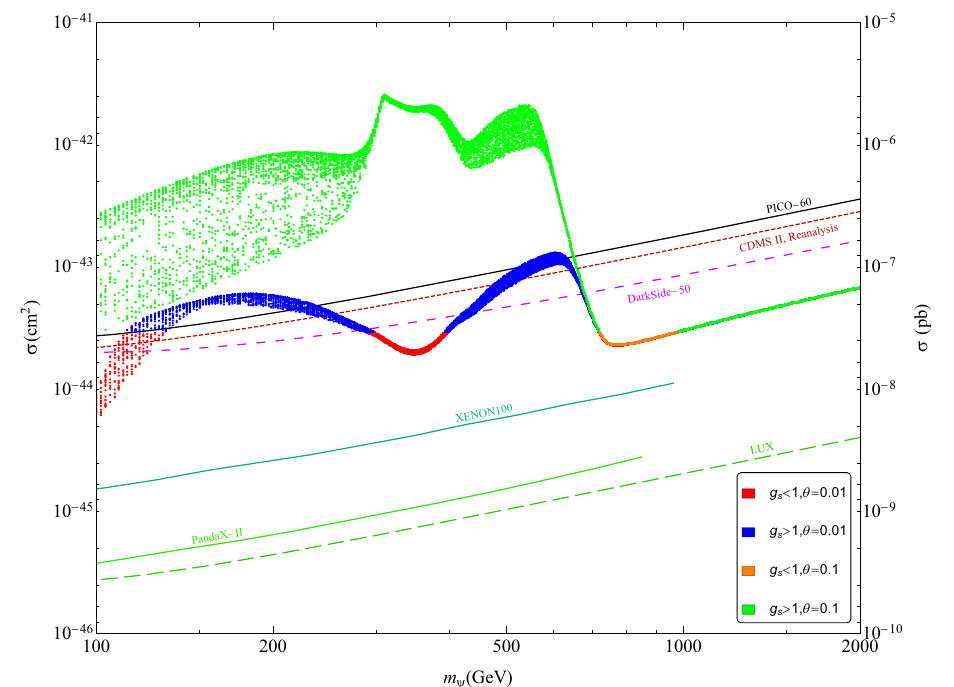
Fig. 4 The elastic scattering cross section off a nucleon in terms of m ψ for two different values of Higgs mixing angle; θ = 0 . 01 and θ = 0 .